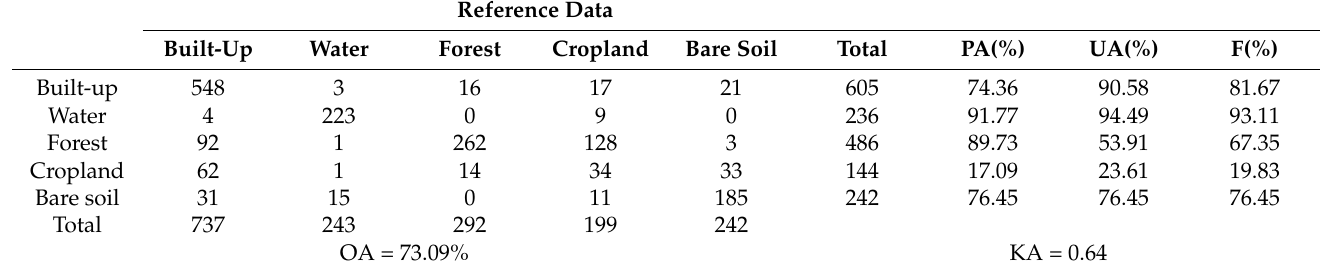
Table 3. Confusion matrix of the classification results using only the Sentinel-1A SAR data.